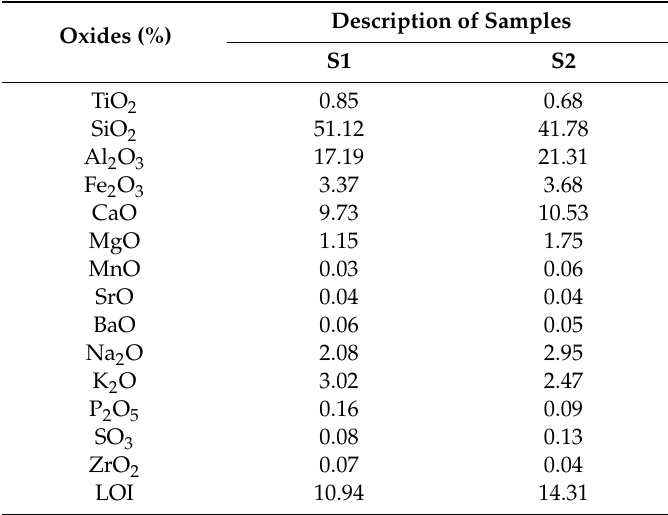
Table 4. Results of the chemical composition analysis of samples after